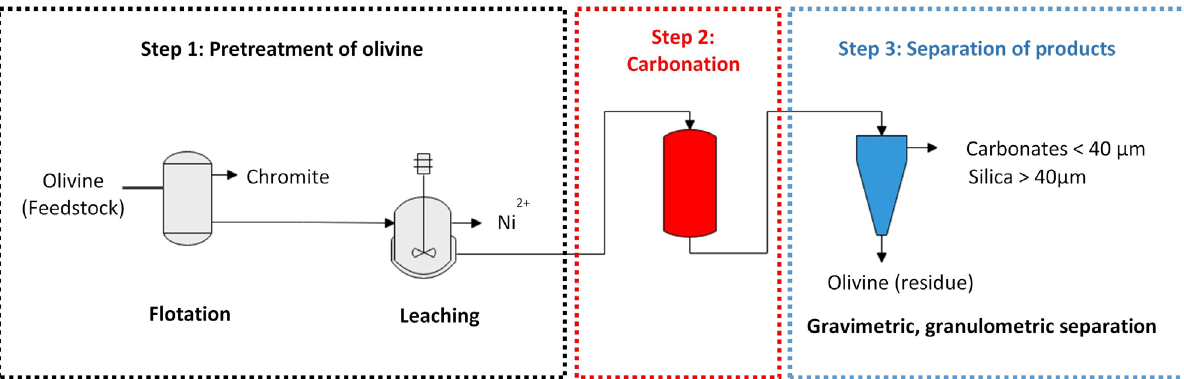
sequestration by direct carbonation of 2